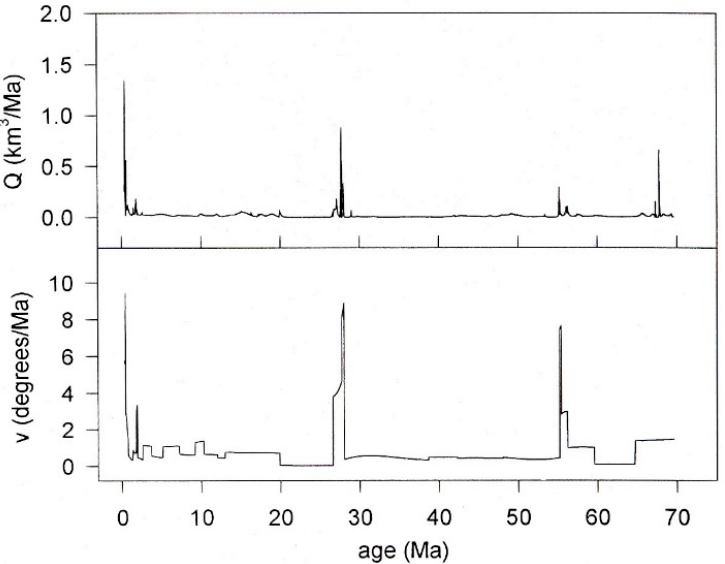
Figure 7. Electrocardiogram of the Earth, or magma emplacement rate Q per unit time from the Hawaii hot spot during the last ~ 70 Ma , and measured speed v of the drift of the lithosphere. Estimates are derived by formal interpolation over the volume of the outpoured islands and seamounts vs. their respective age. The resolution time is 100,000 years . Figure after Gregori and Dong (1996) [13], and Gregori (1997) [4]. See also Gregori (2002) [2]. See text.